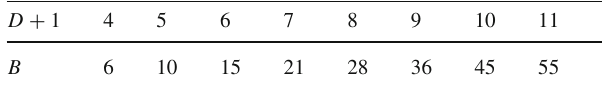
( D ) with respect to q